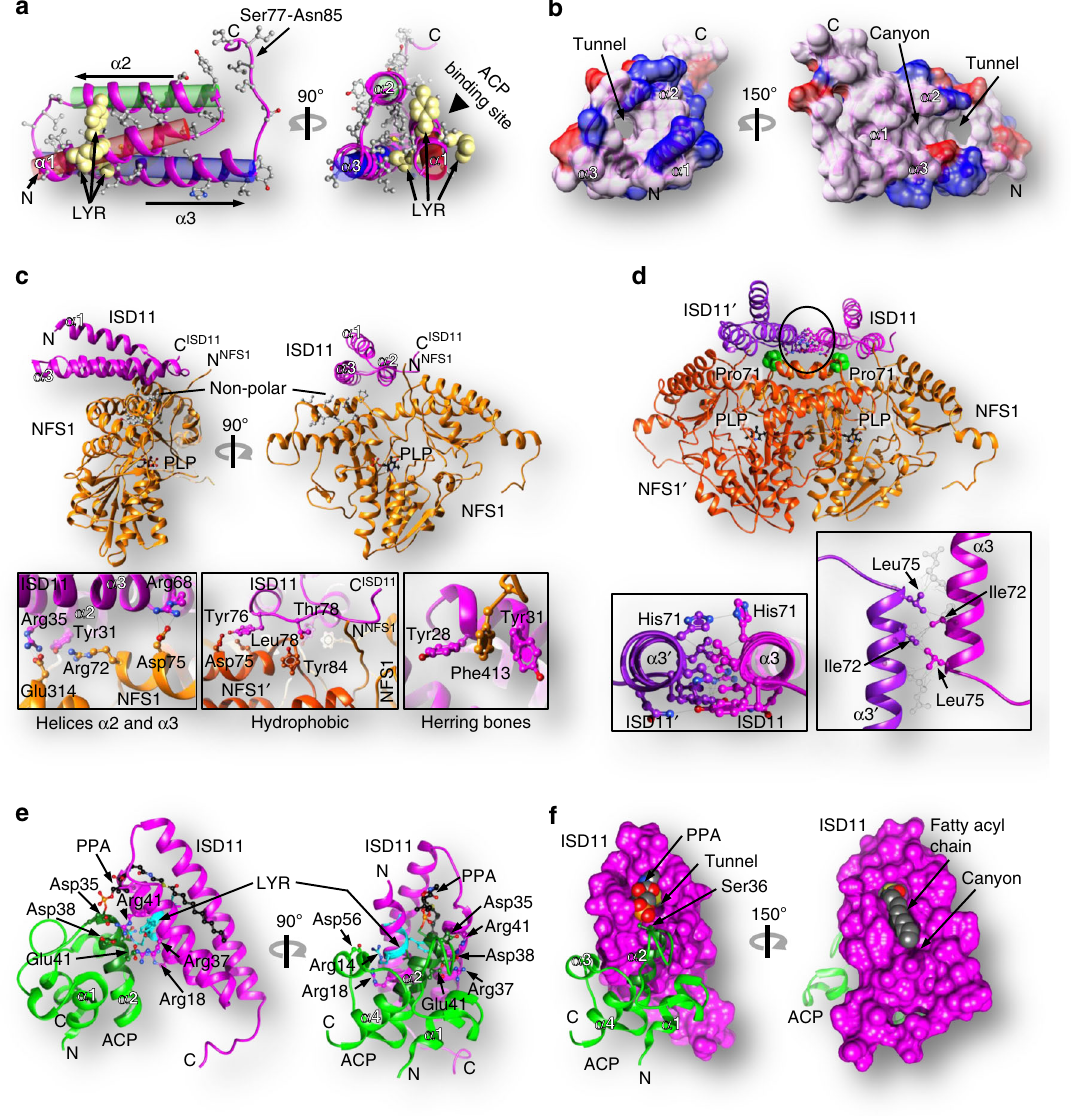
Fig. 3 Structure of ISD11 alone and in complex with NFS1 or ACP. Structures of subunits and sub-complexes were taken from the (NIAU) 2 complex. a Structure of ISD11. All hydrophobic residues found in ISD11 are in gray. Helices α 1 (red), α 2 (green), and α 3 (blue) are antiparallel ( α 2 and α 3) or tilted by ~21° ( α 1). N and C termini are marked. The LYR motif is shown in khaki by spheres. b Surface representation of ISD11 shows a hydrophobic tunnel between the three α -helices and a canyon. Surface is colored in light-magenta except for positively and negatively charged residues in blue and red, respectively. c Hydrophobic and polar interactions between ISD11 (magenta) and NFS1 (orange). Boxes show details of the interaction interfaces. d Interaction of the ISD11 and NFS1 dimers. Insets show details of ISD11 – ISD11 interaction. e Structure of the ISD11-ACP sub-complex. Phosphopantetheine with a fatty acyl chain (PPA) is colored in black, and the LYR motif in cyan. f Surface representation of ISD11 in the ISD11-ACP sub-complex shows that PPA (red balls) and part of the fatty acyl chain (gray balls) bind to a hydrophobic canyon of ISD11, while the rest of the fatty acyl chain penetrates the hydrophobic tunnel of